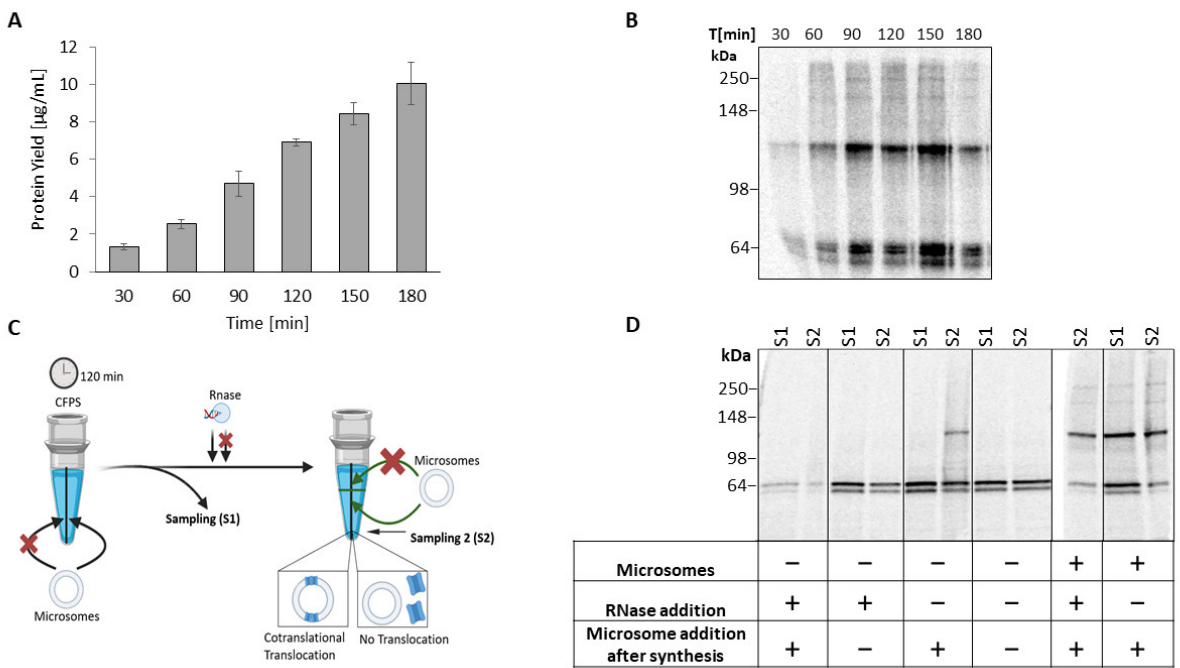
Figure 2. TREK–2 assembly in eukaryotic cell-free synthesis. TREK–2 was synthesized in Sf 21 lysate and 14 C labeled. The vesicular fraction (VF) was analyzed. ( A ) Quantitative analysis of time series by liquid scintillation counting. Standard deviations were calculated from triplicates. ( B ) Autoradiogram of time series depicting protein bands of TREK-2 by a non-denatured SDS–PAGE (4–12% Tris–Glycine). ( C ) Schematic diagram of assembly experiment. ( D ) Autoradiogram of assembly experiment de- picting protein bands of TREK-2 by a non-denatured SDS-PAGE (4–12% Tris-Glycine) with varied synthesis conditions: with or without microsomes; supplemented microsomes from the beginning or after 120 min; RNase addition. Rearranged: original autoradiogram, Figure